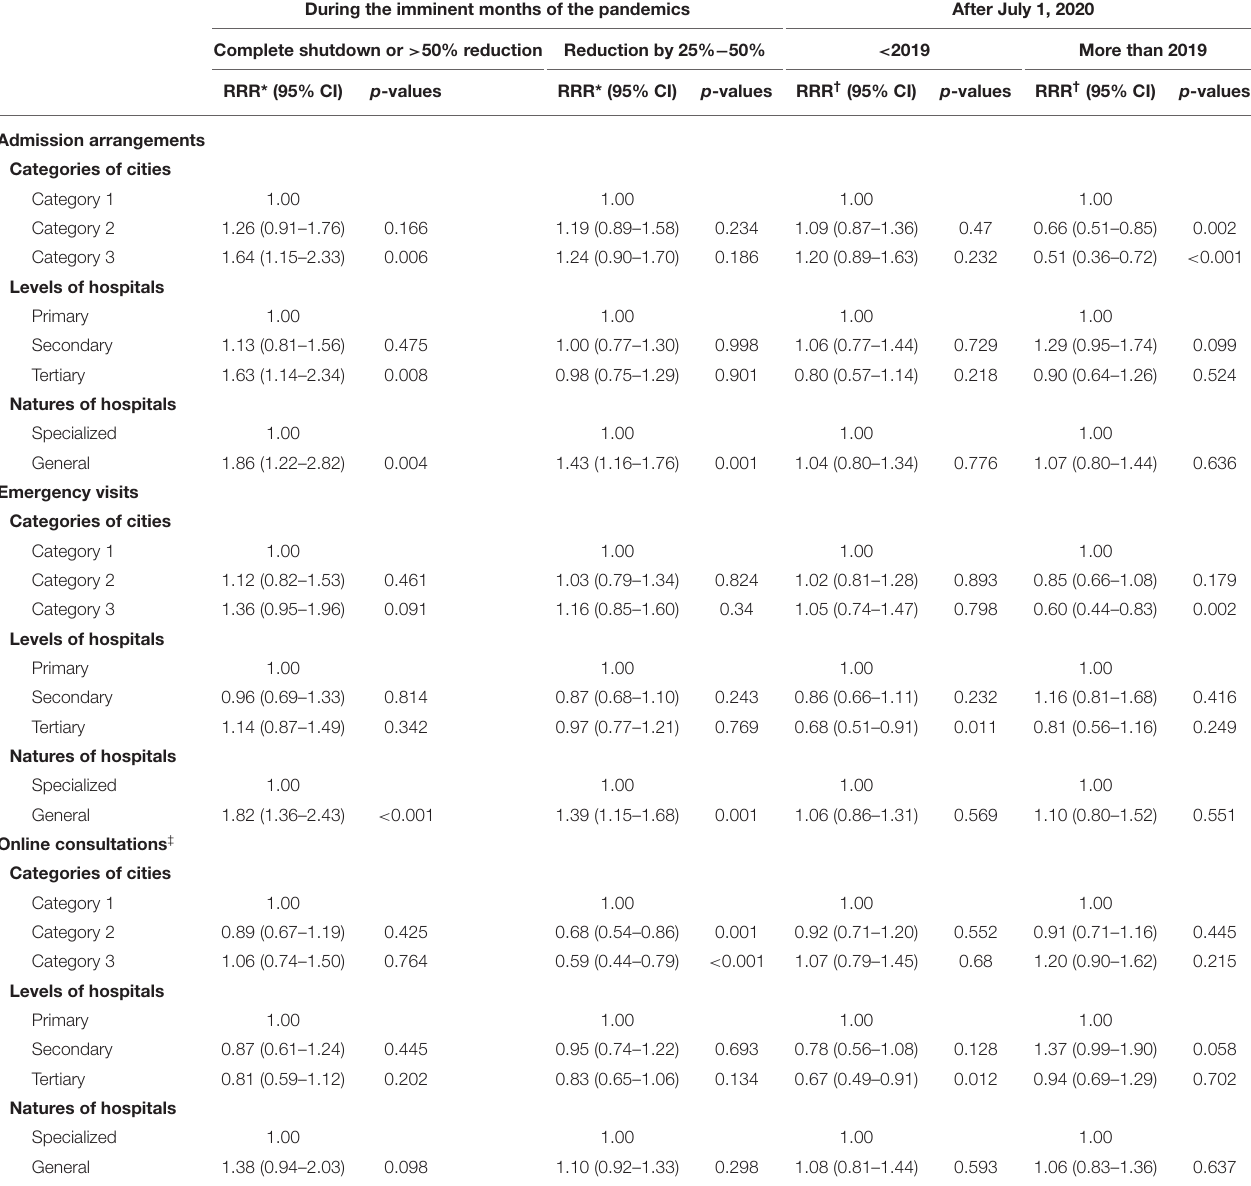
The categories of cities were based on the total number of hospital beds. In categories 1, 2 and 3 cities, the total numbers of beds were fewer than 10,000; 10,000–30,000; and more than 30,000, respectively. 95% CI, 95% confidence interval;. RRR, relative risk ratio.